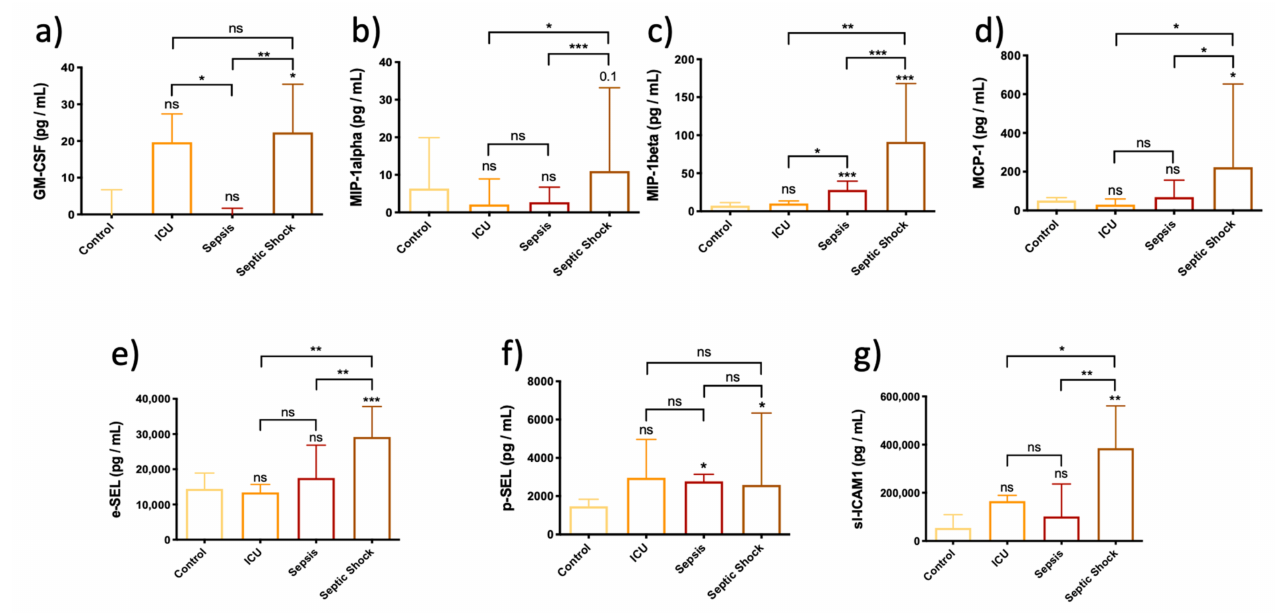
Figure 4. Bar graph (Median ± IQR) of circulating levels of monocyte and neutrophil mediators in control, ICU, sepsis and septic shock patients. ( a ) Circulating levels of GM-CSF; ( b ) Circulating levels of MIP-1 α ; ( c ) Circulating levels of MIP-1 β ; ( d ) Circulating levels of MCP1; ( e ) Circulating levels of e-SEL; ( f ) Circulating levels of p-SEL; ( g ) Circulating levels of s-ICAM1. Each sample was measured in duplicate. ns = non-significant p value; * p < 0.05; ** p < 0.01; *** p < 0.001. The lines at the top of the box plots indicate differences between compared conditions. The number of subjects analyzed were as follows: control ( n = 10); intensive care unit (ICU) ( n = 5); sepsis ( n = 10); septic shock (SS) ( n =